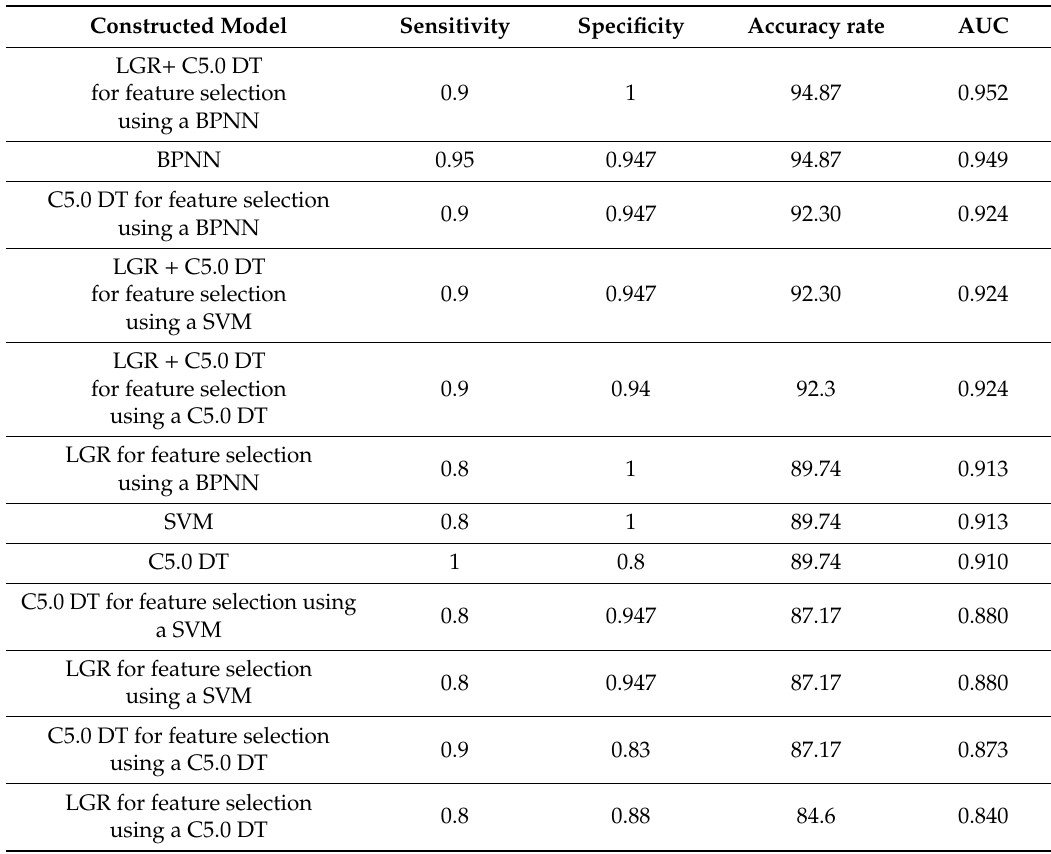
Table 4. Comparison of each assistive diagnostic